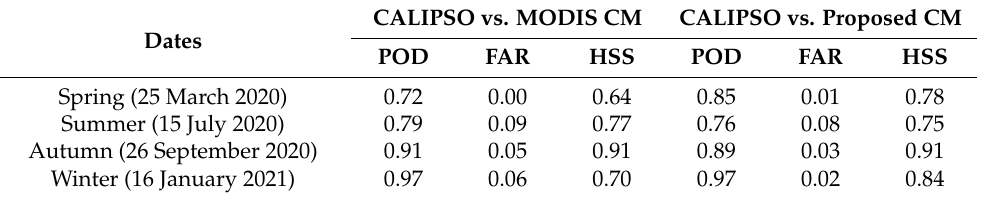
Table 4. Statistical comparison of the proposed CM and MODIS CM using the CALIPSO data.